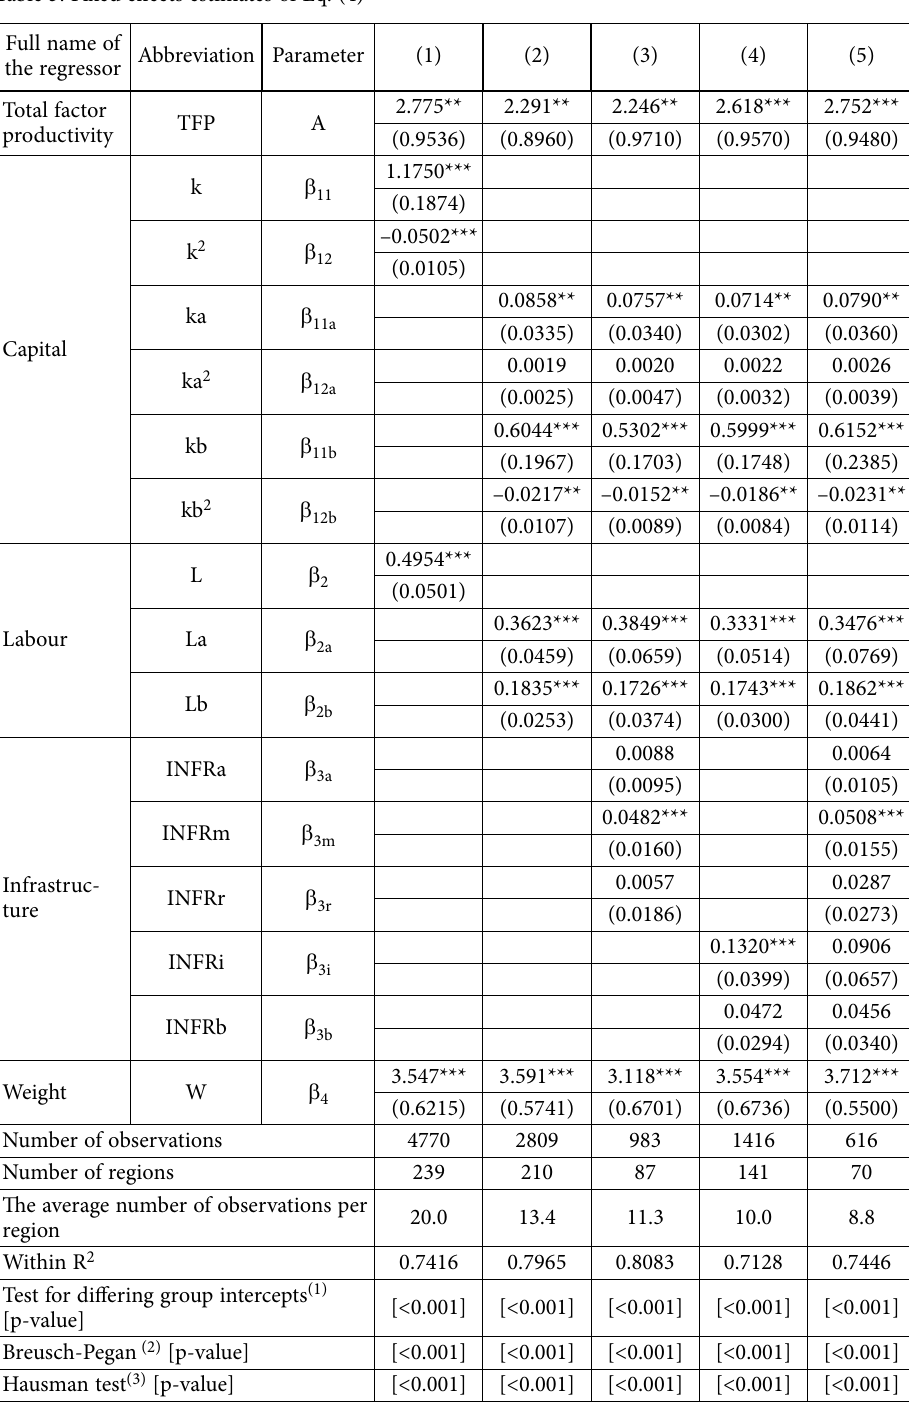
Table 3. Fixed effects estimates of Eq.